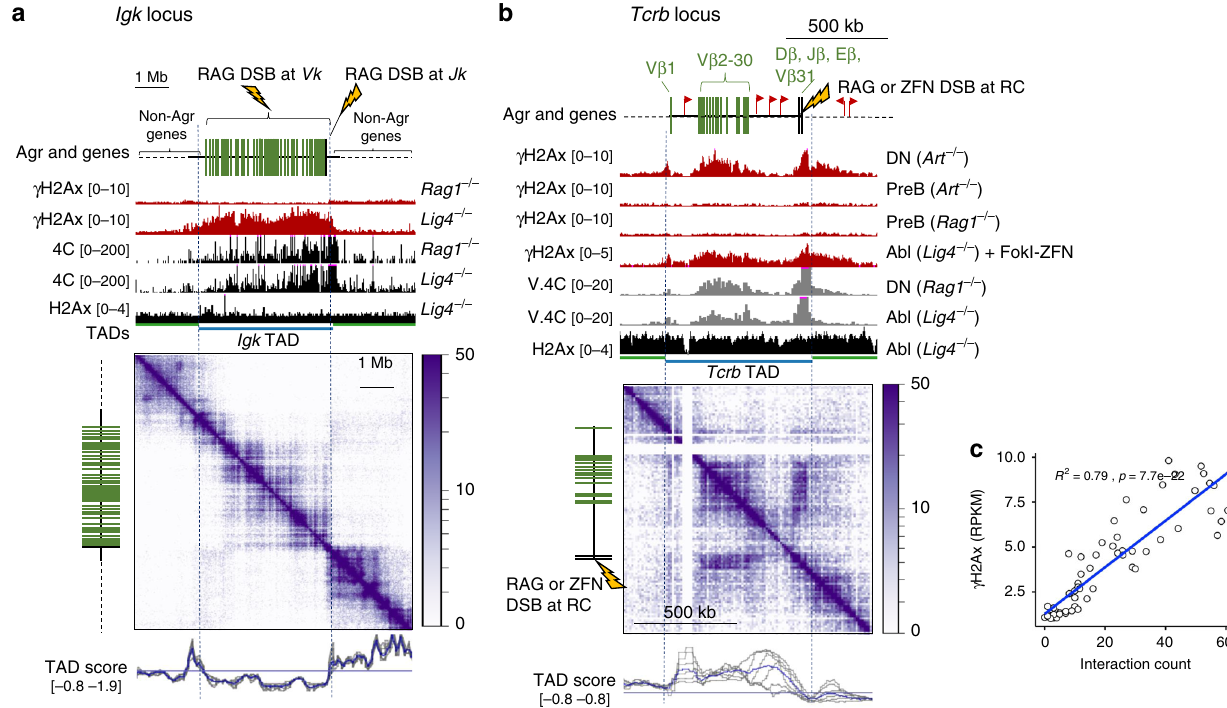
Fig. 1 H2Ax phosphorylation is con fi ned to antigen receptor loci following RAG-mediated DSBs. Genome browser snapshots of the a Igk or b Tcrb antigen receptor regions. Each panel includes diagrams indicating antigen receptor loci, genes, and DSB location (lightning bolt) on top. a Igk locus snapshot of data derived from G1-arrested v-abl pre-B cells following Imatinib treatment (72 h). UCSC genome browser tracks show RPKM-normalized histograms for γ H2Ax ChIP-seq (mean of three independent replicates), Jk interactome 4C-Seq (representative of two independent replicates), and H2Ax ChIP-seq (representative of two independent replicates) for indicated v-abl cell genotypes. The bottom Juicebox snapshot shows Hi-C data derived from G1-arrested Lig4 − / − cells ( n = 2, merged independent samples). Scale indicates interaction counts. The IGV tracks under the Hi-C data show topologically associated domains (TADs), which are assigned based upon TAD insulation scores, derived from 40 kb bins (blue lines) or 20 – 100 kb bins (gray lines). b Tcrb locus snapshot with data derived from both primary and G1-arrested v-abl cells. The UCSC genome tracks show RPKM-normalized histograms for γ H2Ax CR-seq ( n = 2, representative of independent replicates), Tcrb -RC viewpoint virtual V.4C-seq ( n = 2, merged independent replicates), and H2Ax ChIP-seq (representative of two independent replicates) for indicated Abl cell genotypes. To generate V.4C tracks, 10 kb-binned Hi-C data were extracted for the RC viewpoint and plotted. Bottom: Hi-C Juicebox plot derived from Rag − / − DN thymocytes ( n = 2, merged independent samples). The tracks under the Hi-C data show TADs and their insulation scores as in (a ). c DN thymocyte Pearson ’ s correlation of γ H2Ax RPKM and interaction counts in 5 kb windows across Tcrb